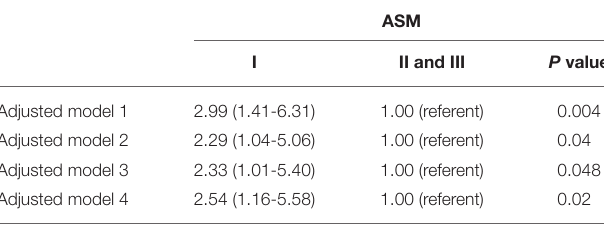
TABLE 3 | Prevalence of metabolic syndrome and its individual components according to RMM tertiles among the study population. Central obesity, % (95% CI)